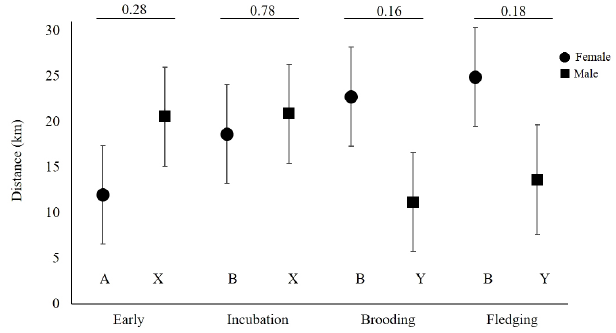
Fig. 2 . Average distance (± 95% confidence interval) flown from the colony to foraging sites of adult Reddish Egrets ( Egretta rufescens ) breeding in the lower Laguna Madre, Texas, during 2010–2016. P-values for within stage comparisons between sexes are indicated above bars, differences among stages within a sex are indicated by letters.